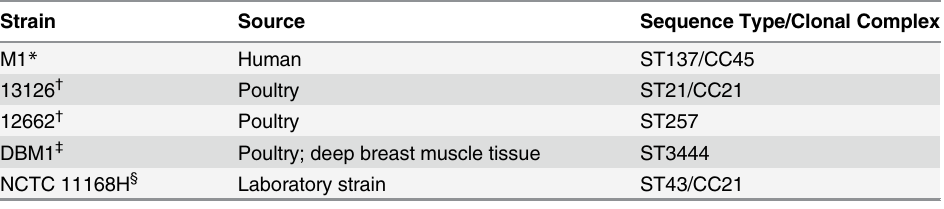
Table 1. C . jejuni strain